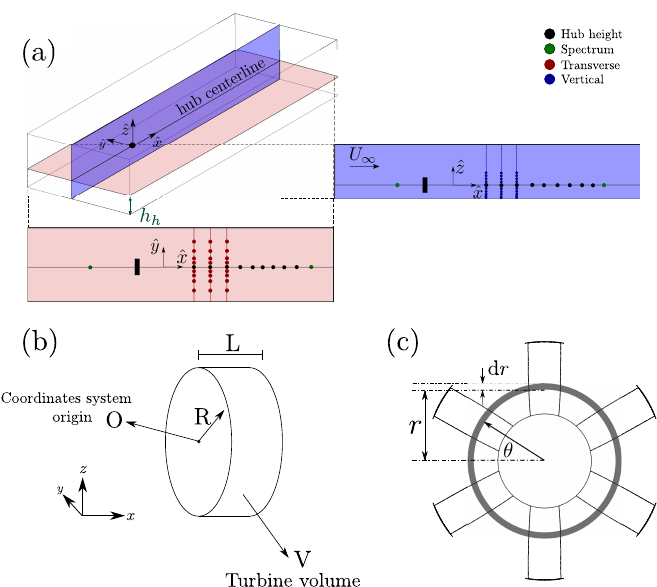
Figure 2. ( a ) Points measured for both cases. Black: hub height ( h h ) for the deficit at the centerline, green: long exposure for the energy spectrum, red: transverse profiles, blue: vertical profiles. The disk on this image represents primary turbine. ( b ) Schematic view of the cylindrical volume V that represents turbines. Forces calculated from BEM theory are only applied over nodes inside this volume. ( c ) Schematic view of the turbine rotor and differential radius dr used on